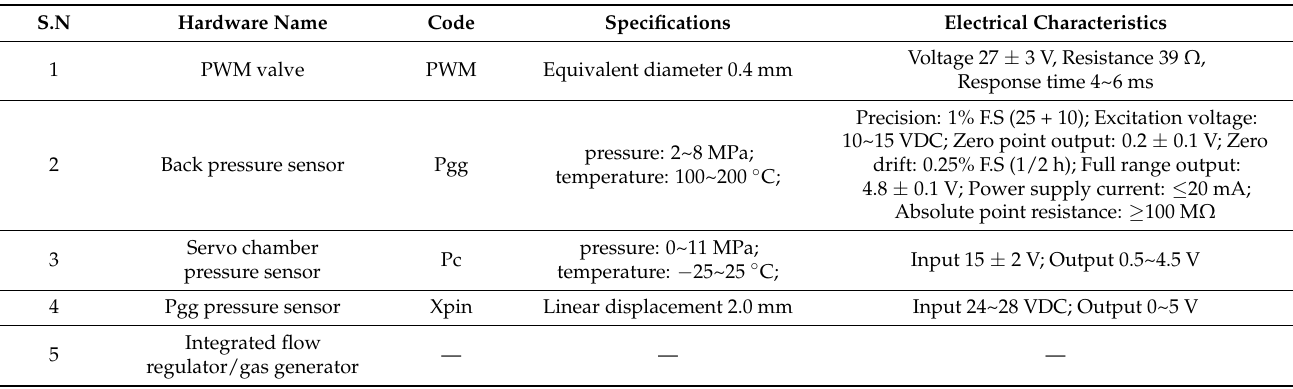
Figure 8. The experiment facilities and process. Table 1. the main working parameters of the hardware participating in the experiment.